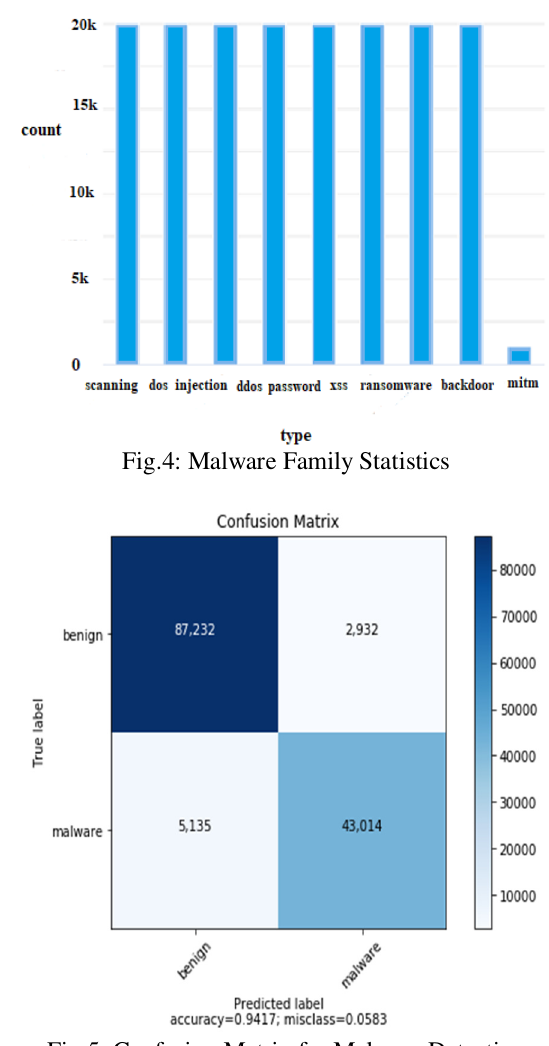
Fig.5: Confusion Matrix for Malware